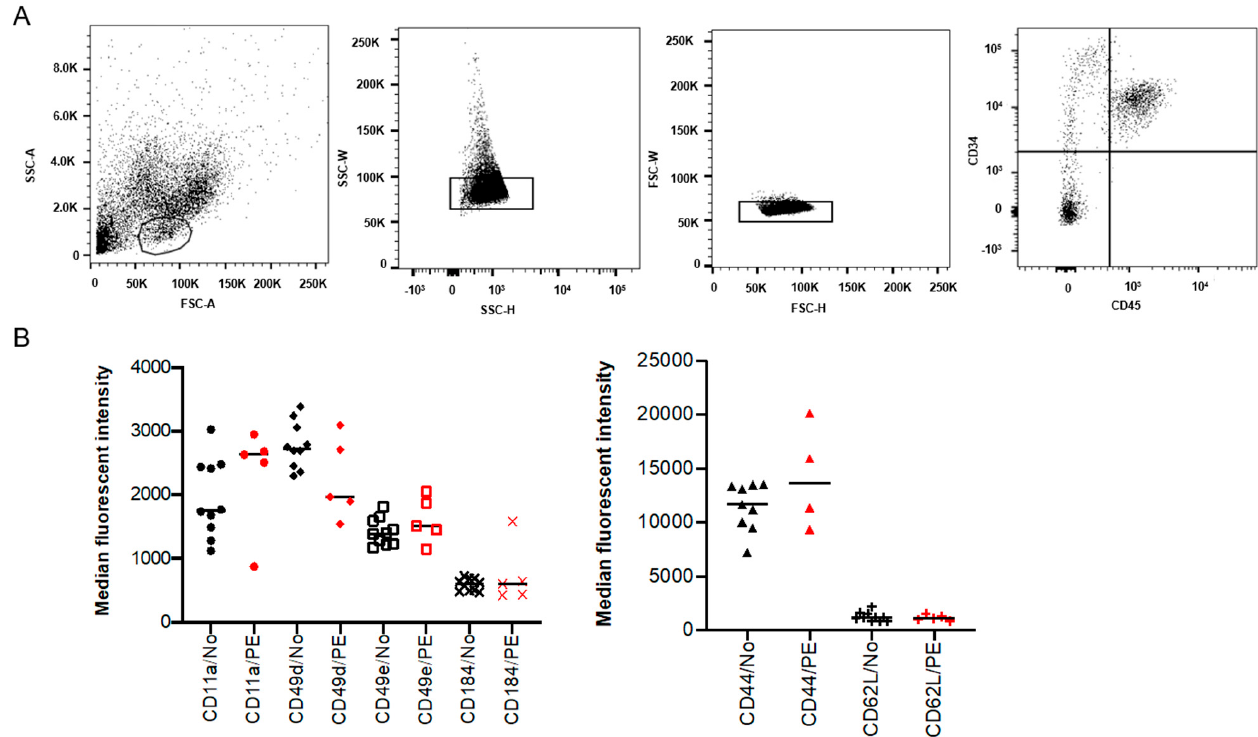
Figure 1. Surface adhesion molecules (SAMs) in isolated placental hematopoietic stem and progenitor cells (HSPCs) from preeclampsia (PE) and normotensive (NO) pregnancies. Flow cytometry analysis showing the isolated placental HSPC population gated based on size and granularity (FSC-A and SSC-A), and CD34 + CD45 + expression ( A ). Demonstrating the percentage of positive cells and median fluorescent intensity (MFI) for various SAMs in black (normotensive) and in red (PE) ( B ). The expression is not significantly different between PE ( n = 5) and normotensive ( n = 10).